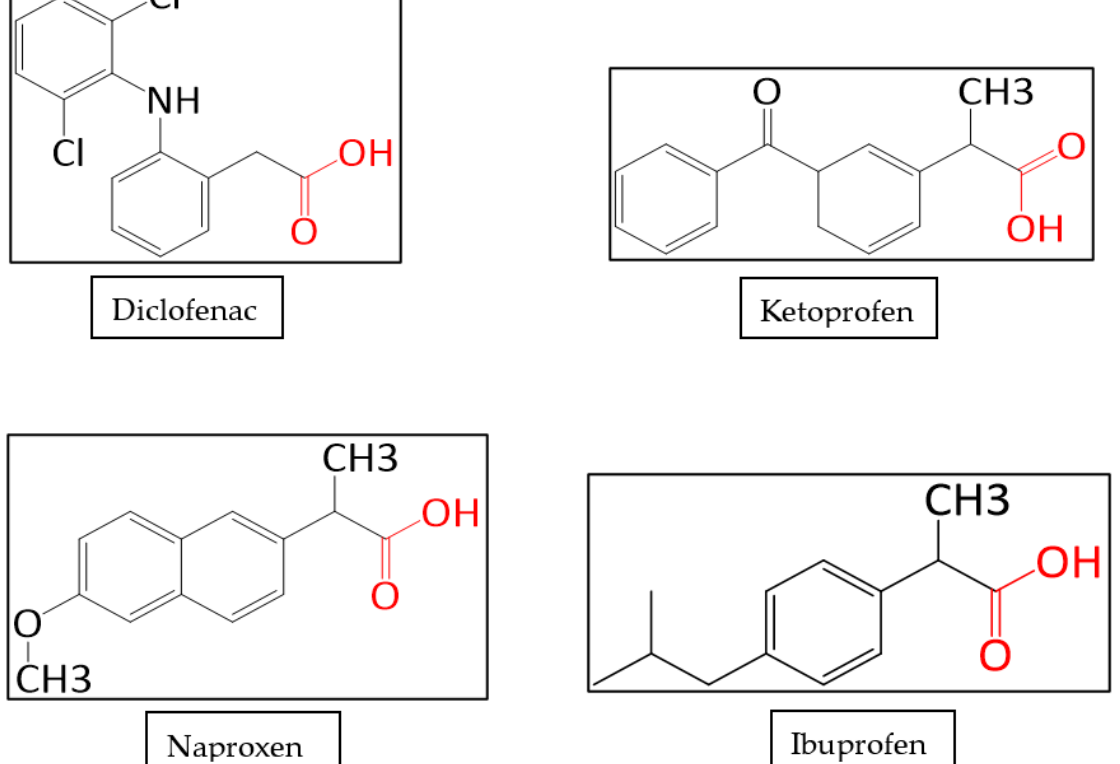
Figure 1. Chemical structure of diclofenac, ketoprofen, naproxen, and ibuprofen.